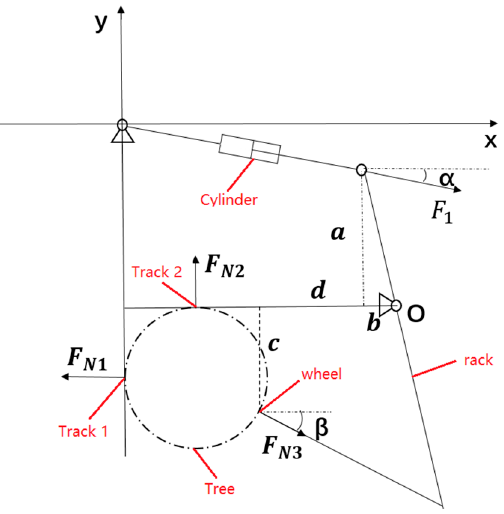
Figure 3. Force analysis diagram